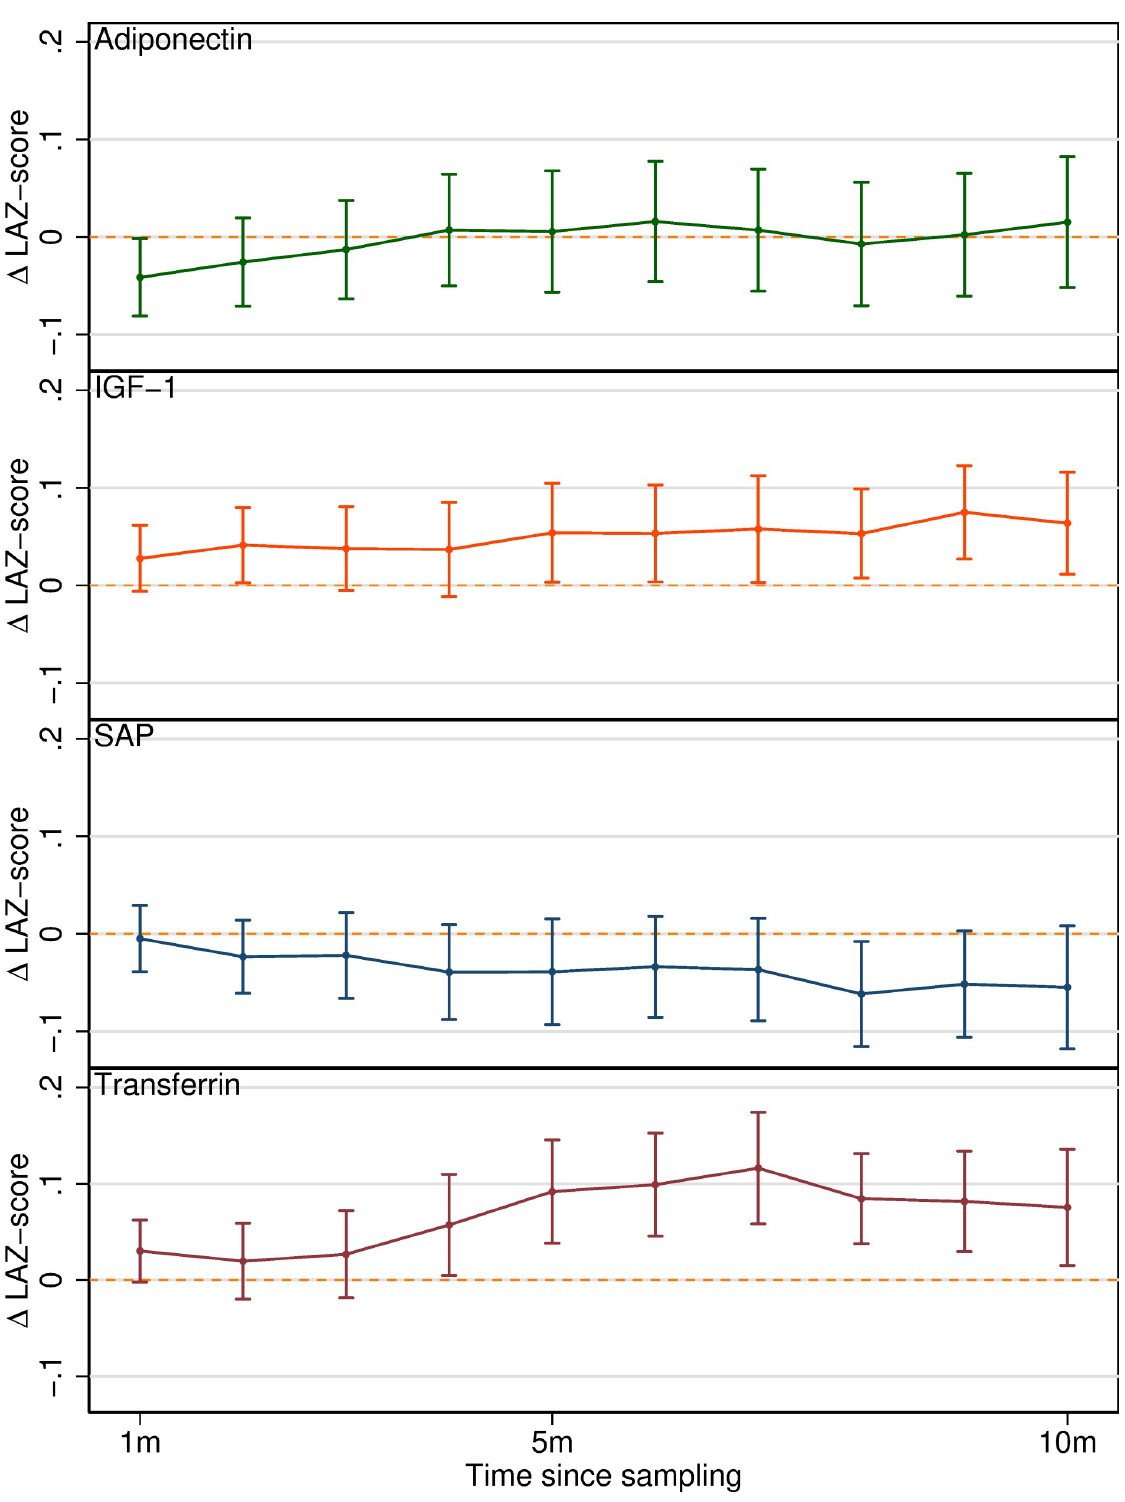
Fig 3. Associations between concentrations of four plasma biomarkers (per standard deviation of their log 2 transformed values) and differences in LAZ-score ( Δ LAZ) over time windows of increasing length, from models adjusting for baseline LAZ, age, and sex.